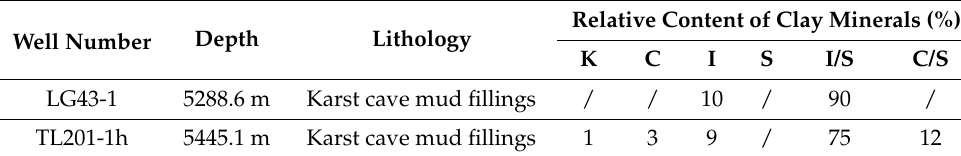
Relative Content of Clay Minerals